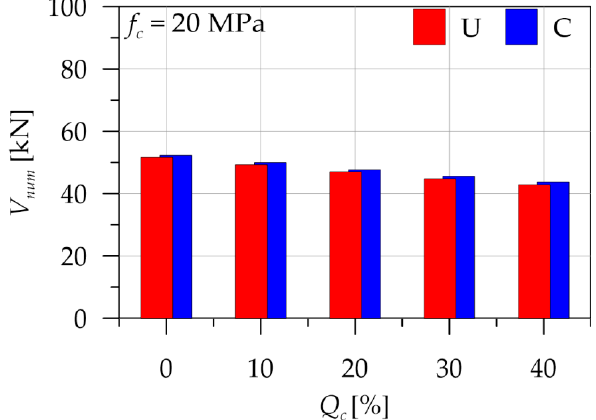
Figure 4. Effect of corrosion degree on the ultimate shear.